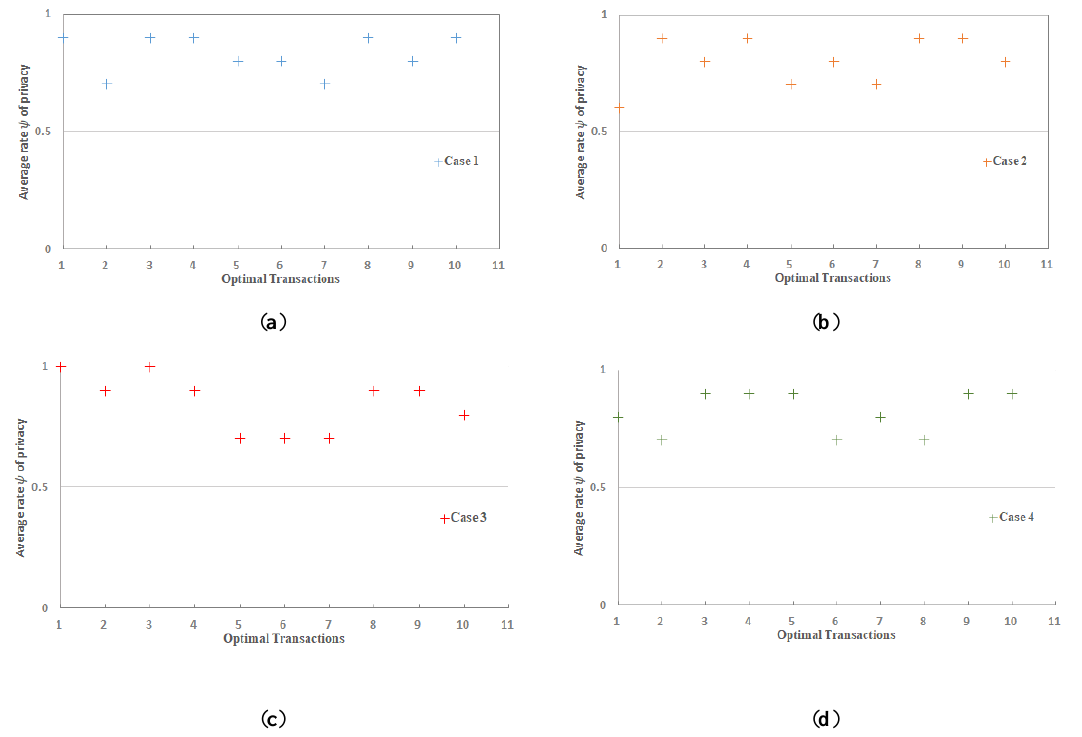
Figure 5. ( a ) Average rate 𝜓 of privacy for Case 1; ( b ) Average rate 𝜓 of privacy for Case 2; ( c ) Average rate 𝜓 of privacy for Case 3; ( d ) Average rate 𝜓 of privacy for Case 4.